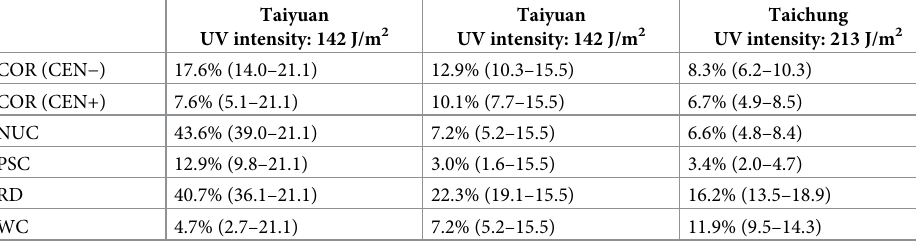
Table 2. Prevalence of the five types of cataract per region.